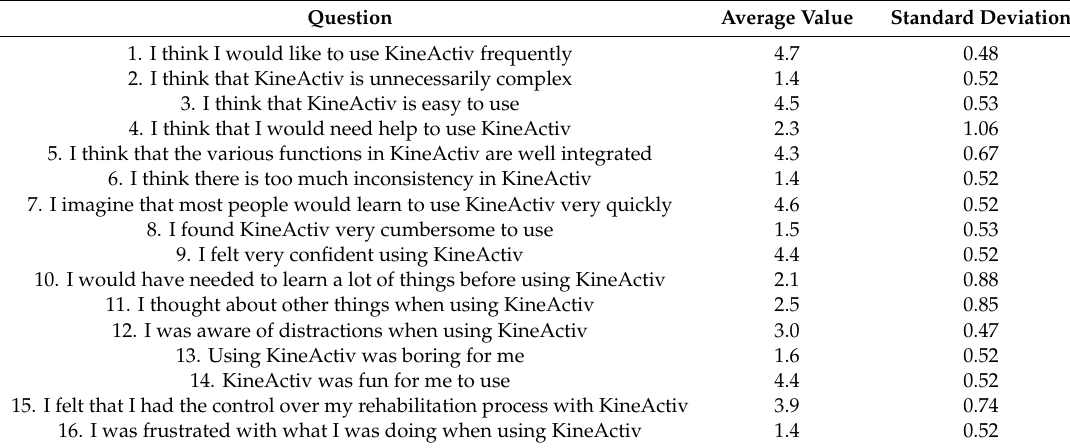
Table 2. Results of the usability study